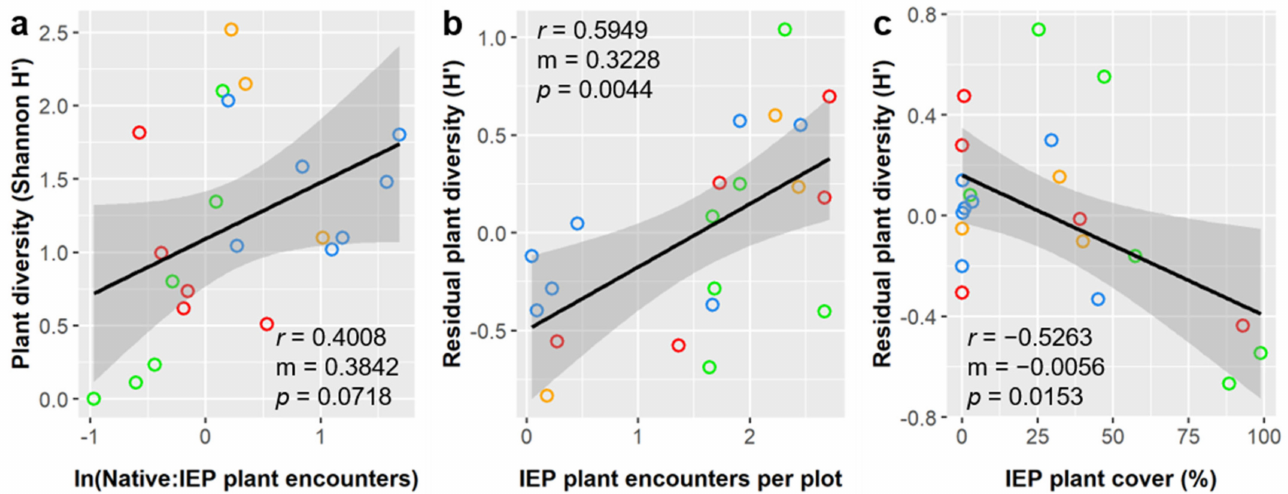
Figure 7. Linear relationships between ( a ) plant diversity and the natural log of the ratio of native to IEP plant encounter rates, ( b ) residual plant diversity and IEP plant encounter rate, and ( c ) residual plant diversity and IEP plant cover. Open circles denote values from one study site and are colored to denote habitat class as follows: red, S TX Disturbed Grassland; orange, Tamaulipan Lomas; green, Tamaulipan Shrubland; blue, Texas Coastal Prairies. Legend: r , Pearson correlation coefficient; m, slope from the regression model (effect size); p , p -value from the regression model (see Table S7 for p -values from the ANCOVA